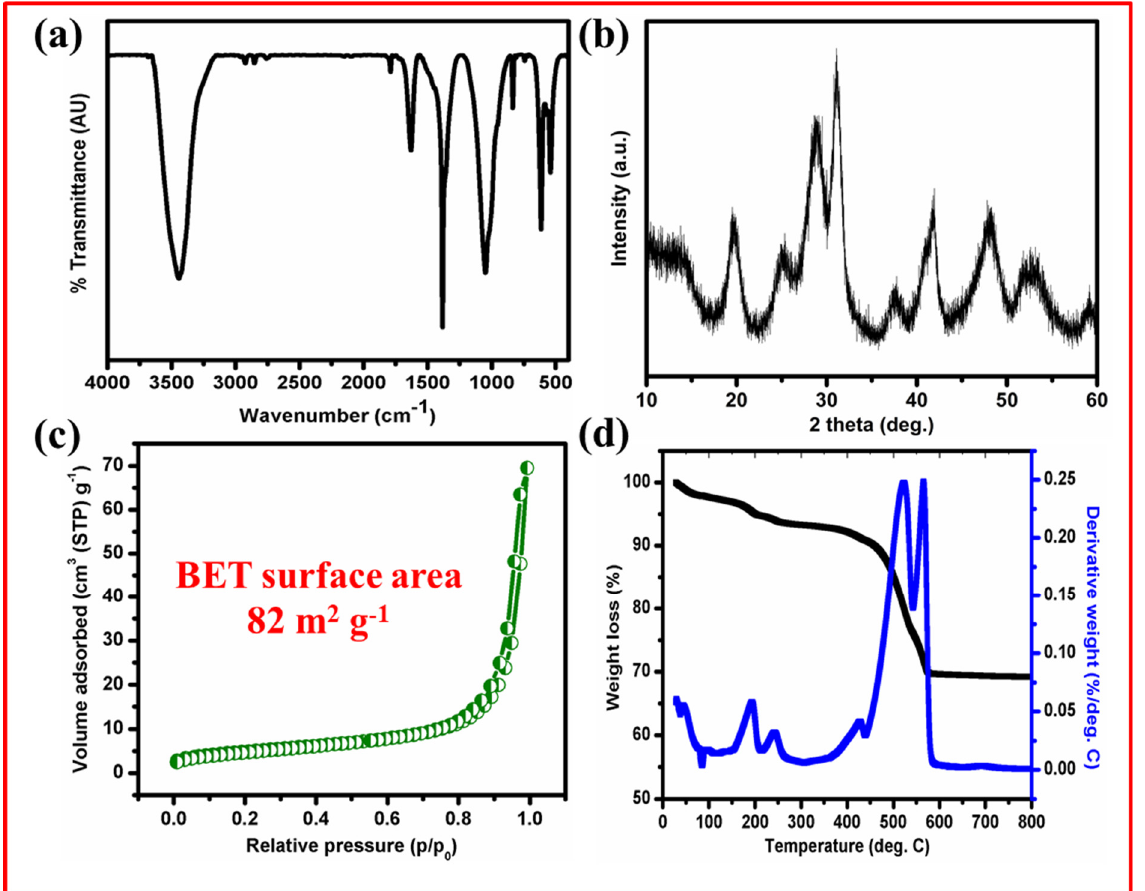
Figure 2. ( a ) FTIR, ( b ) XRD, ( c ) nitrogen sorption isotherm, and ( d ) TGA/DTGA of prepared Ce(HPO 4 ) 2 .xH 2 O.